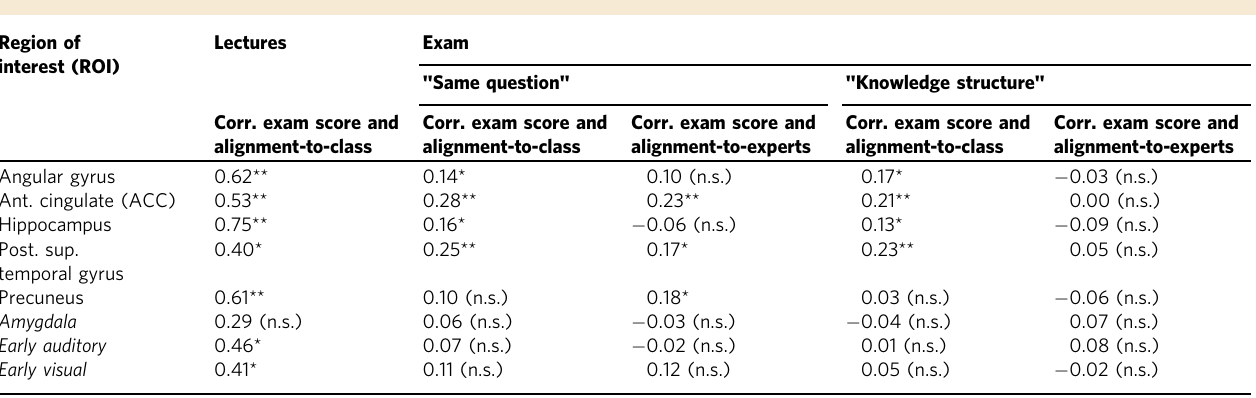
Table 2 Prediction of exam scores from neural alignment in